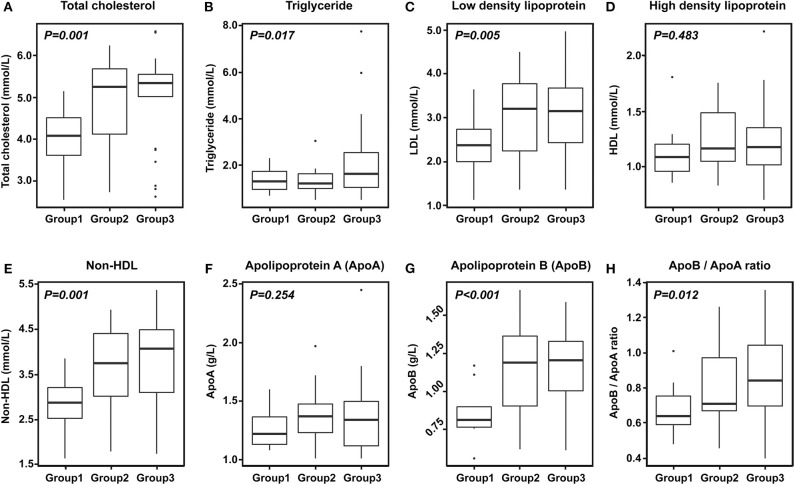
Degree of enhancement of intracranial atherosclerosis according to lipid levels. (A) Total cholesterol. (B) Triglyceride. (C) Low density lipoprotein cholesterol. (D) High density lipoprotein cholesterol. (E) Non-HDL cholesterol. (F) Apolipoprotein A. (G) Apolipoprotein B. (H) ApoB/ApoA ratio. Group 1: no enhancement, Group 2: mild to moderate enhancement, Group 3: strong enhancement.